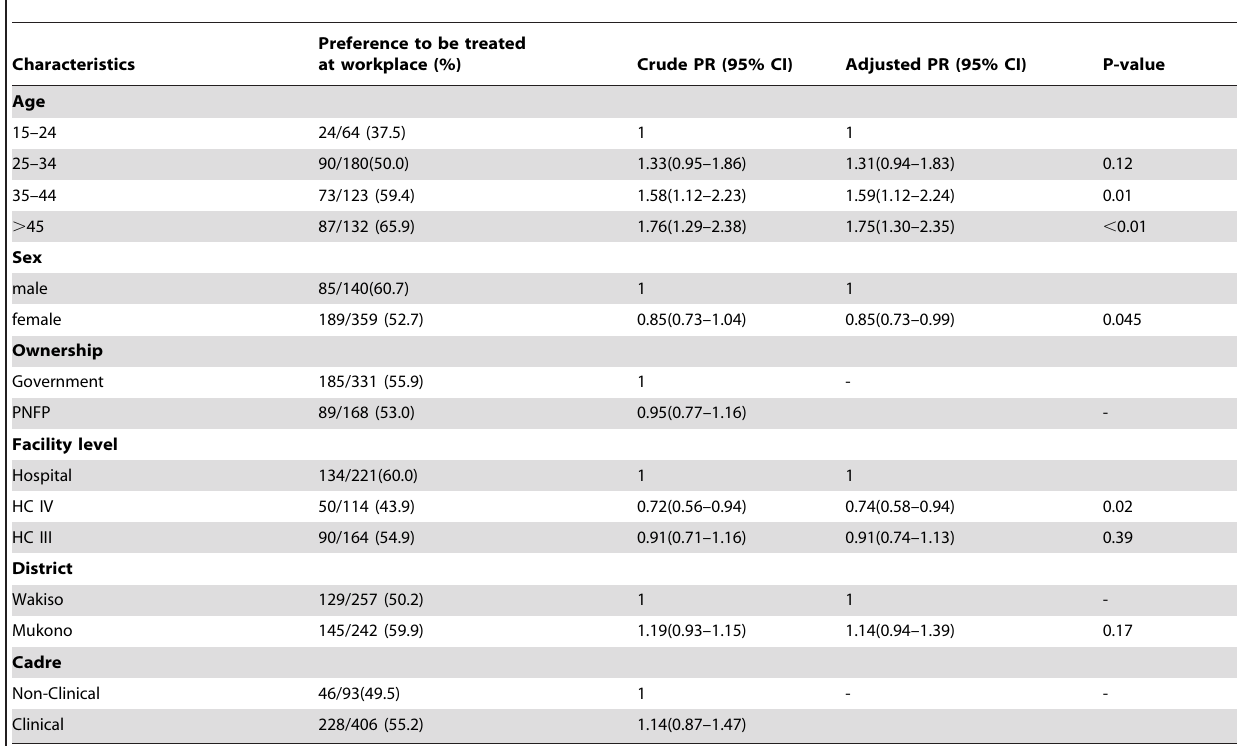
Table 4. Bivariate and multivarable analysis for preference to be treated for HIV at the workplace among health care workers in Wakiso and Mukono in